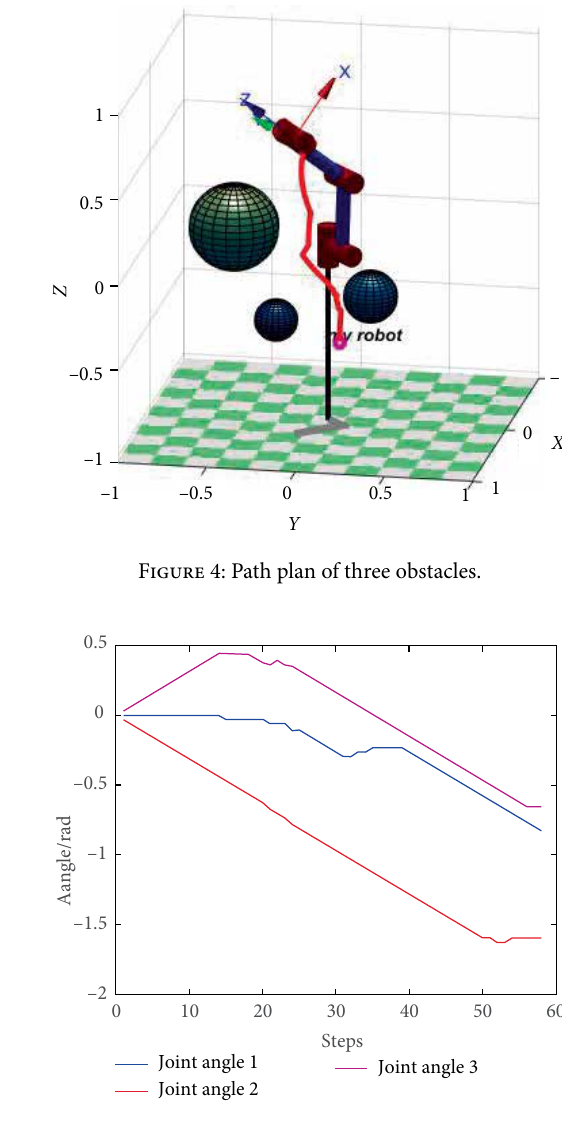
Figure 5: Changes in the joint angle of each.